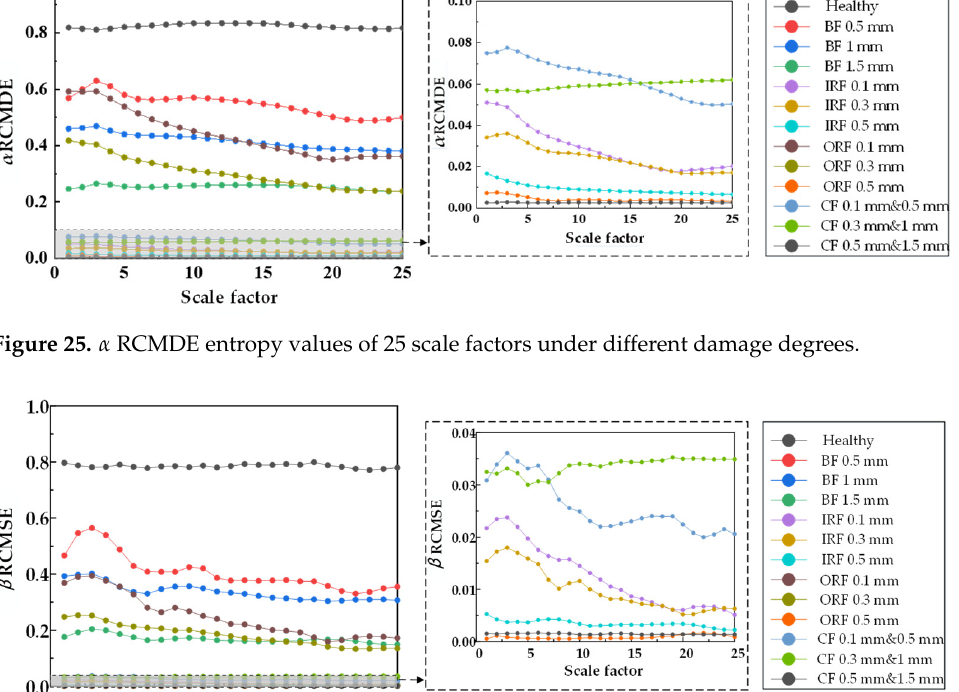
Figure 26. β RCMSE entropy values of 25 scale factors under different damage degrees.